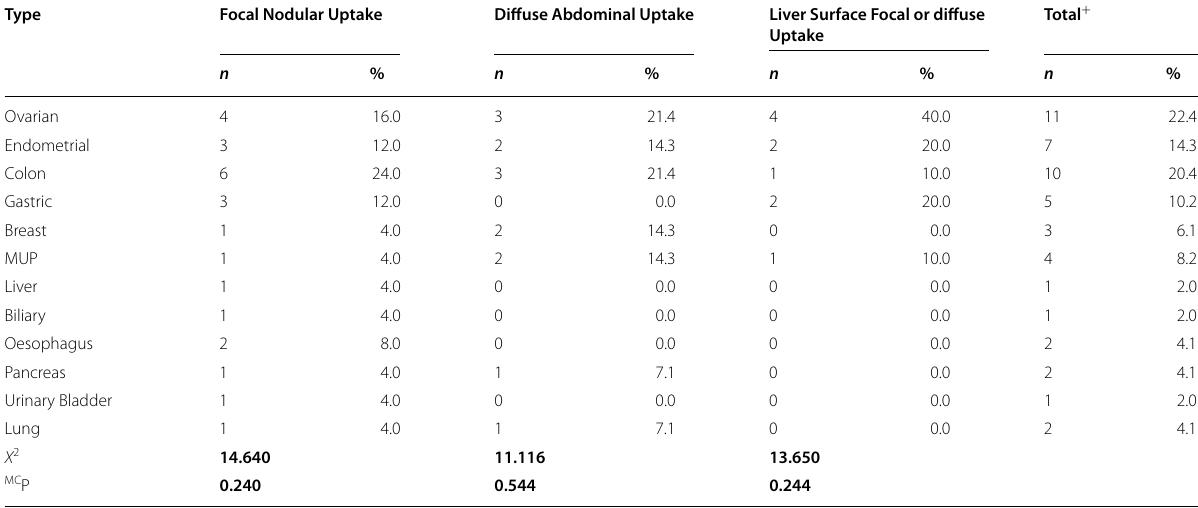
Bold indicates X 2 : Chi-square test, MC: Monte Carlo exact test Data expressed as frequency ( n and %); MUP Metastases of unknown primary; + Most of the included patients showed more than one pattern of FDG uptake of peritoneal metastasis; p probability; Significance < 0.05